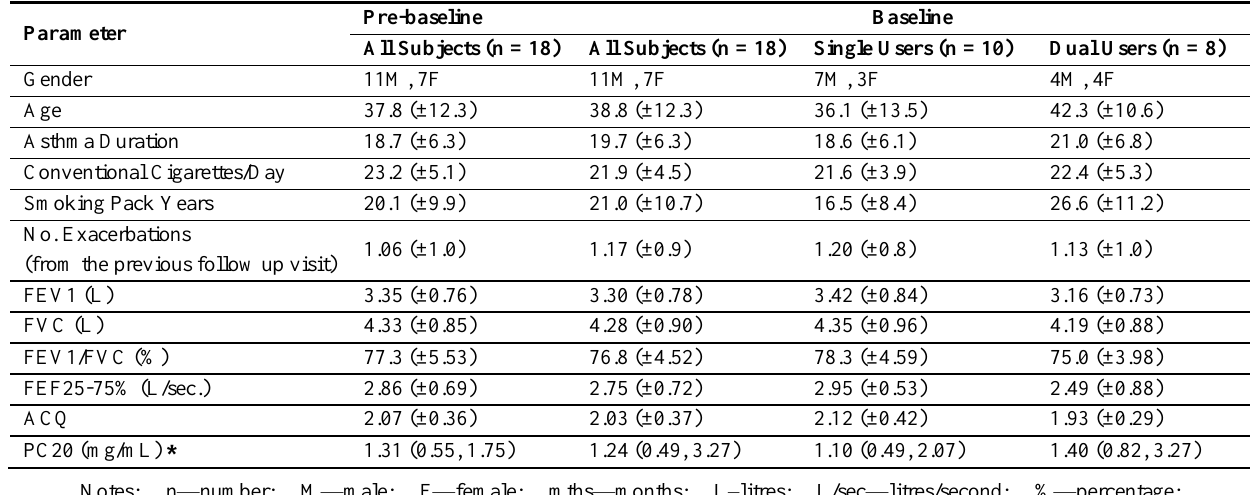
Table 1. Patients characteristics at pre-baseline and baseline (before switching to